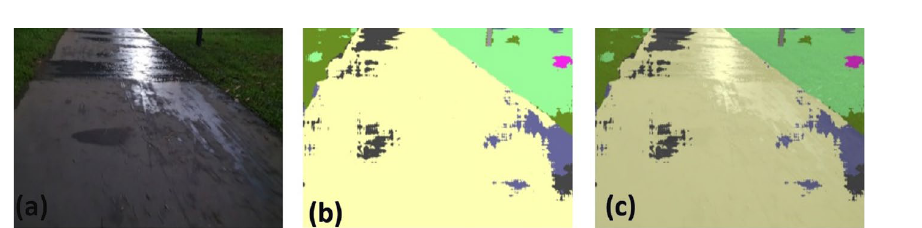
Figure 36. DeepLabv3+ segmentation results: pavement with water puddle.